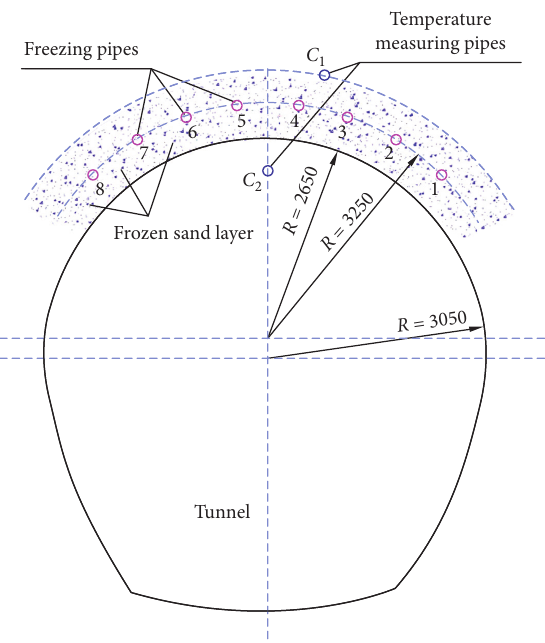
Figure 8: Layout of the freezing pipes in the tunnel.